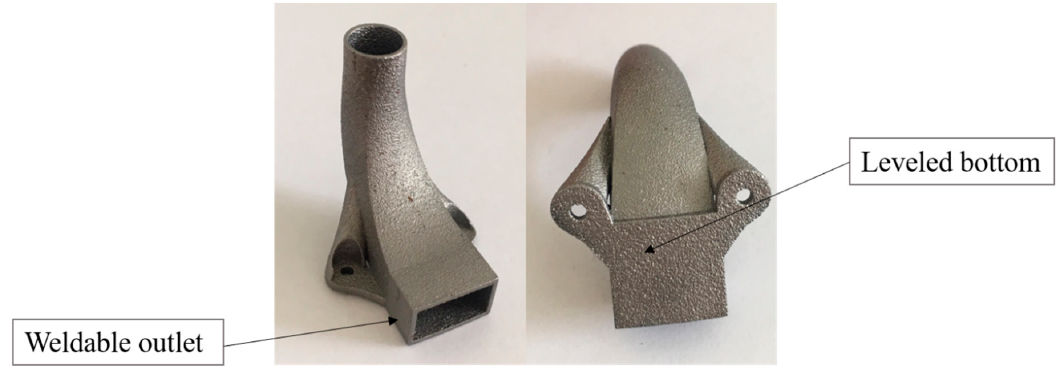
Table 4. AM constraints established after prototyping activities.